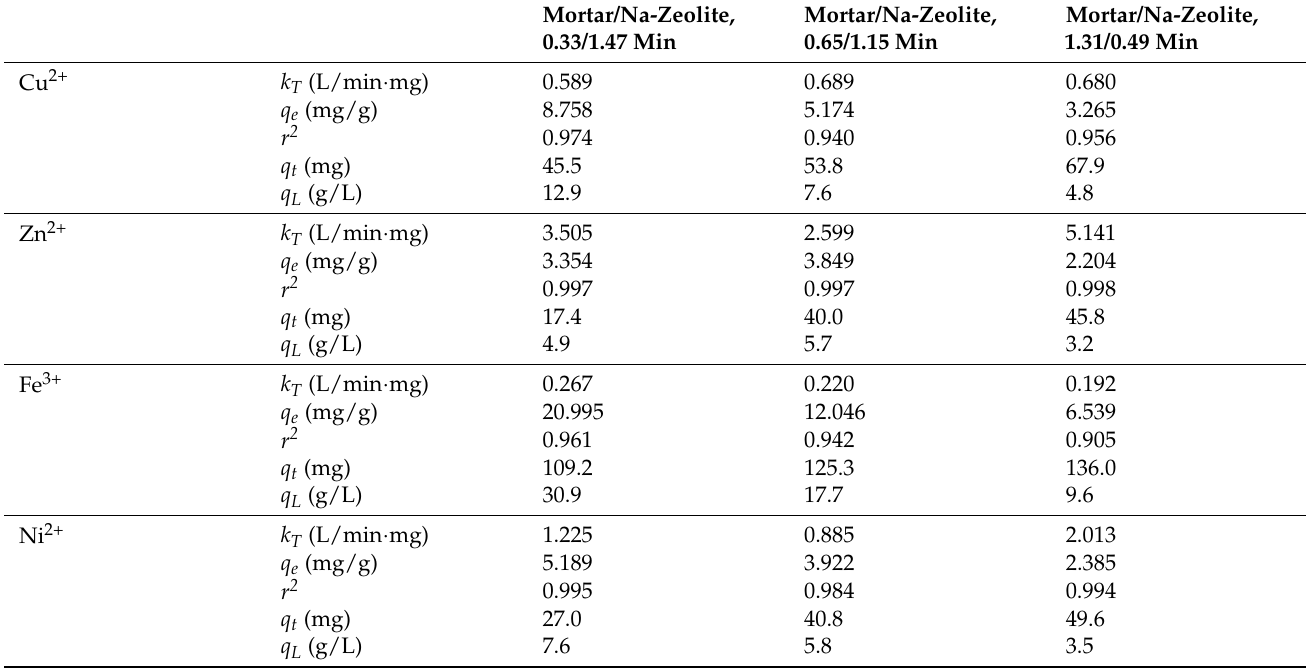
Table 6. Adsorption constants for heavy metals collected from the mortar